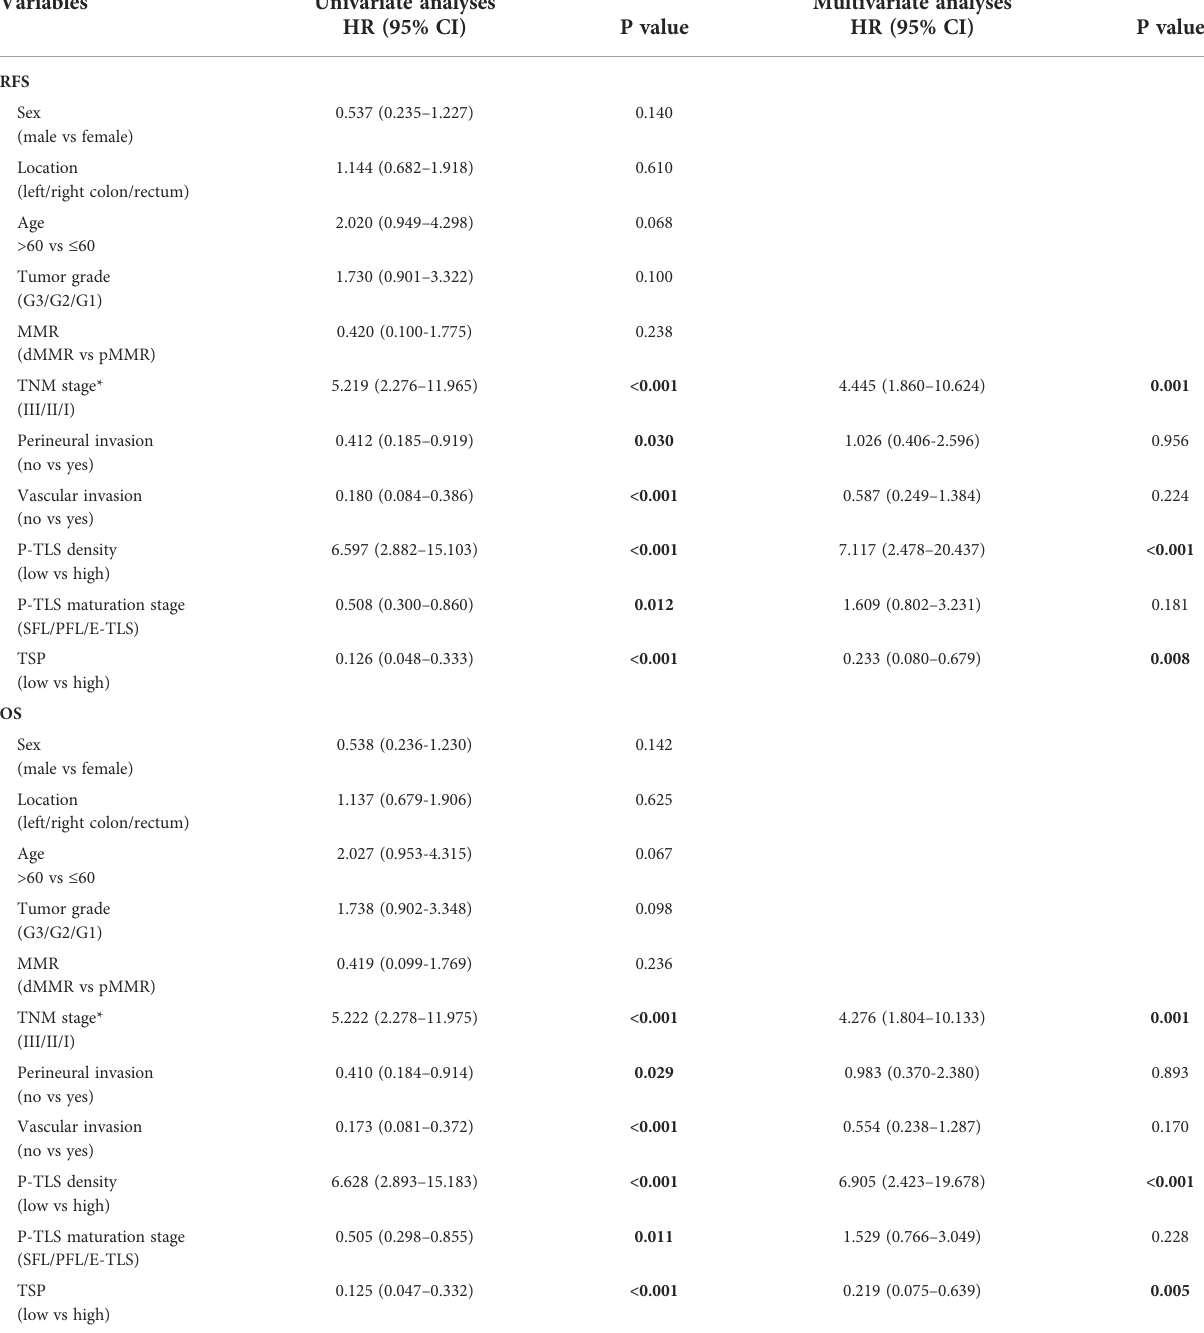
TABLE 3 Cox proportional hazards regression models for the predictors of RFS and OS in the training